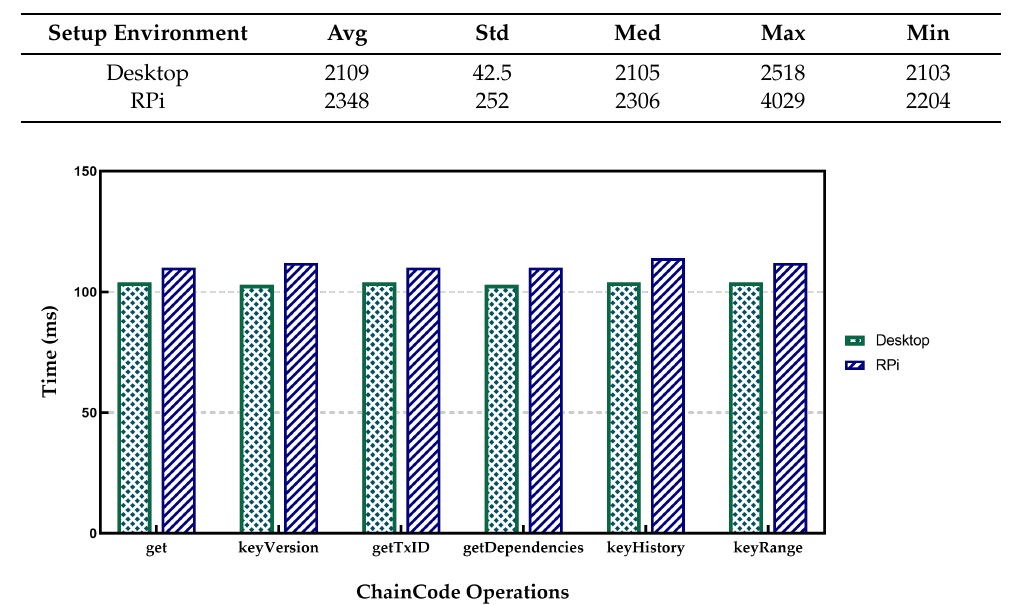
Figure 10. Latency for all ChainCode